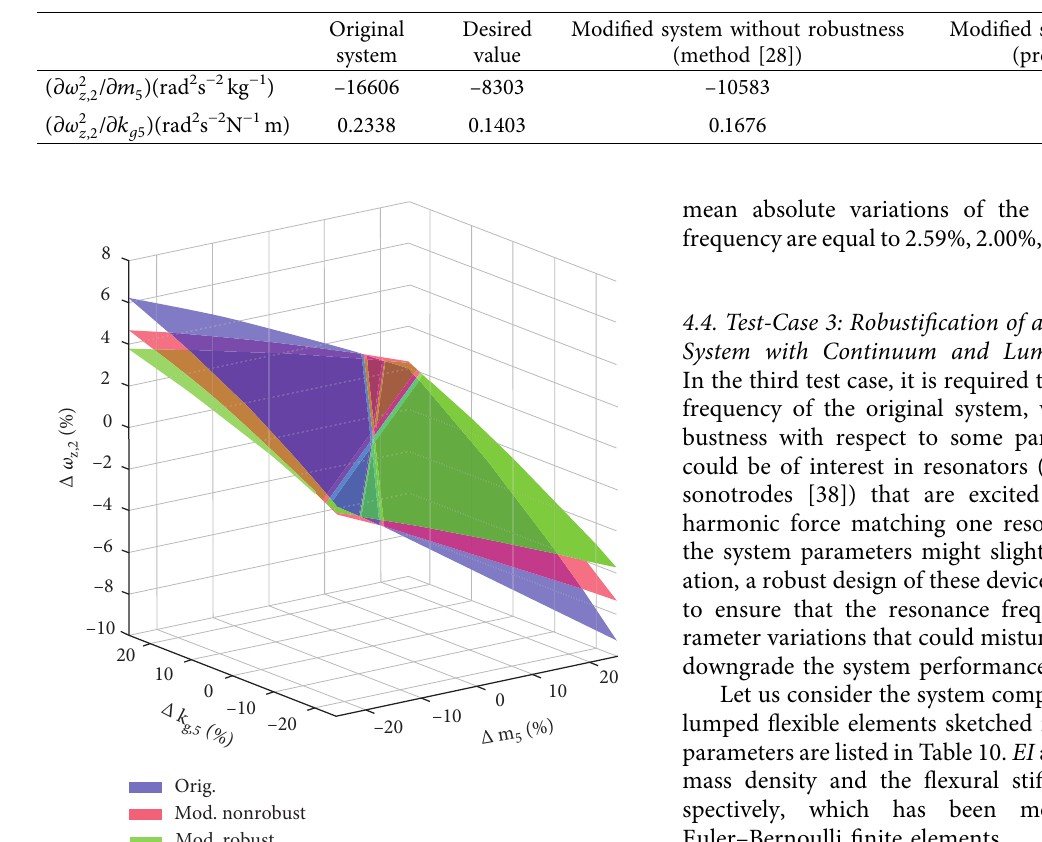
Table 8: Test-case 2: original, desired, and modified systems of h